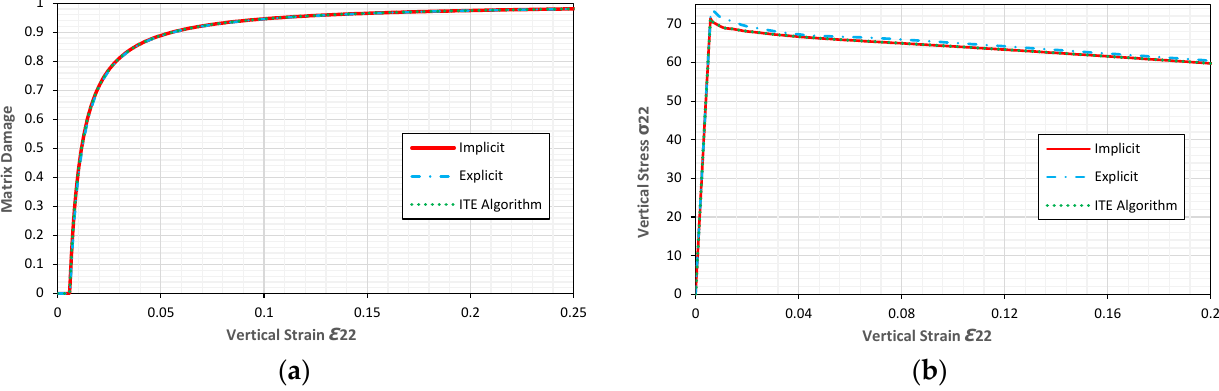
Figure 7. Tensile matrix damage vs. vertical strain ( a ) and vertical stress vs. vertical strain ( b ) for the CT test.